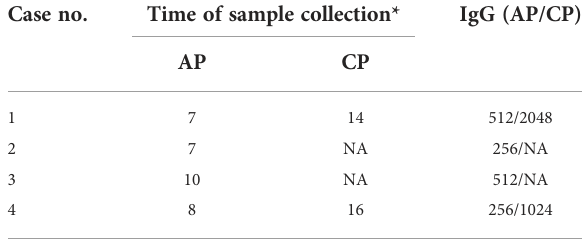
TABLE 4 Serum immunoglobulin antibody titers of the patients with R. felis infection. Case